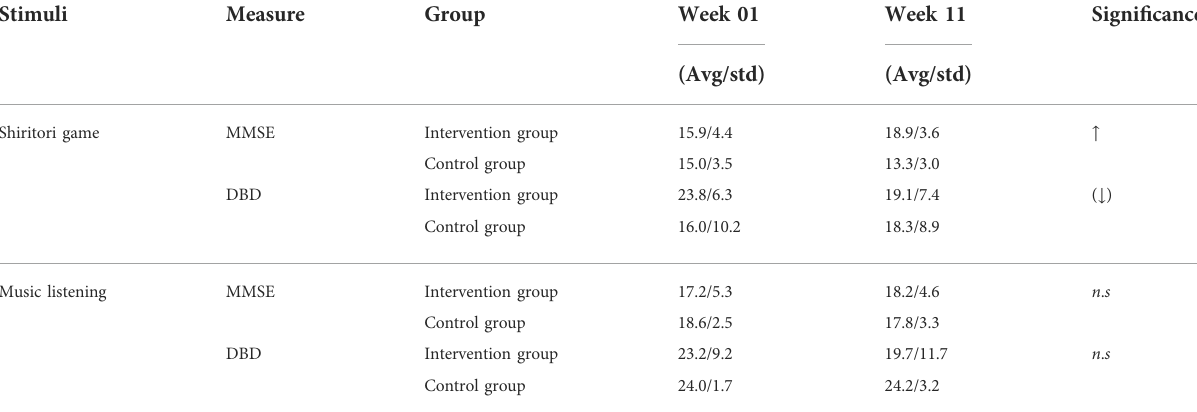
TABLE 3 Signi fi cance test of the differences for MMSE and DBD between Week 1 and Week 11 in the Shiritori game and the music-listening experiment.